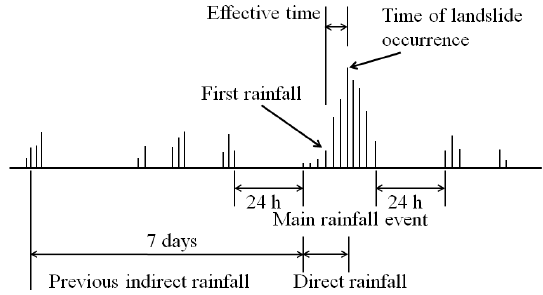
Figure 1. Definition of rainfall events based on effective accumu- lated rainfall (modified from Seo and Funasaki,